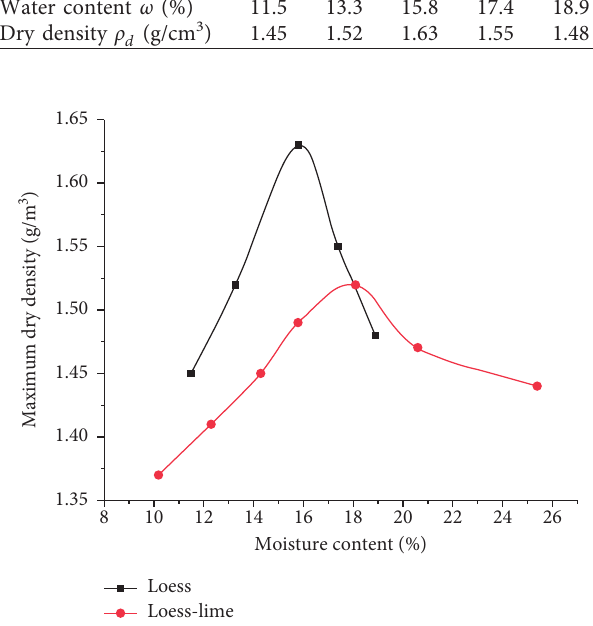
Figure 1: Maximum dry density and moisture relationship curve about loess and